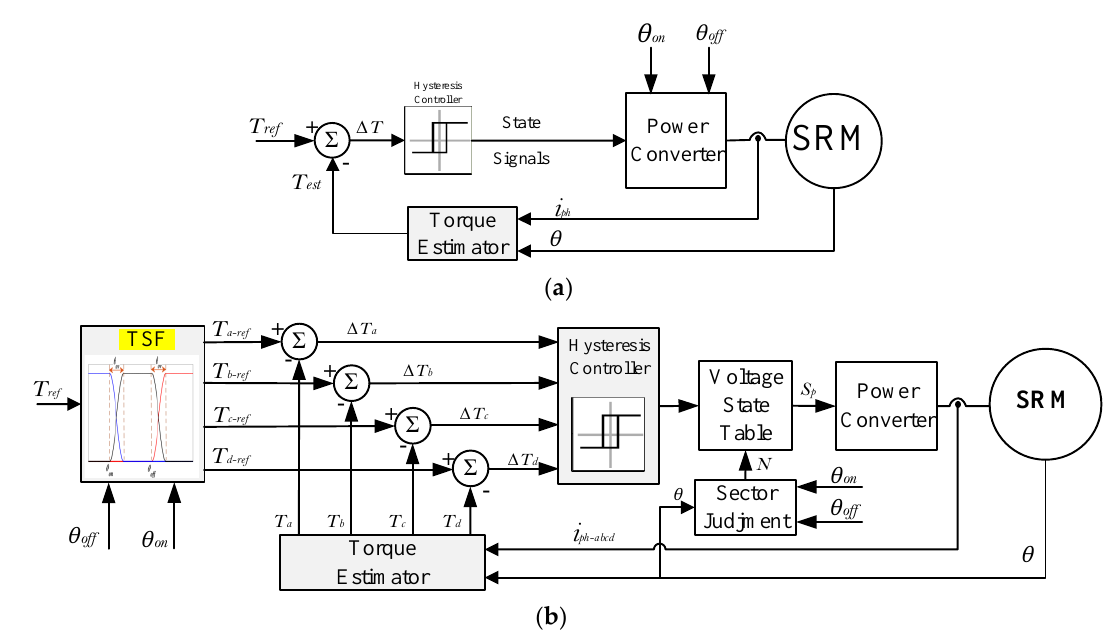
Figure 4. The block diagram of DITC, ( a ) conventional DITC, ( b ) TSF-based DITC. T ref is the reference commanded torque, it comes from an outer loop speed controller.